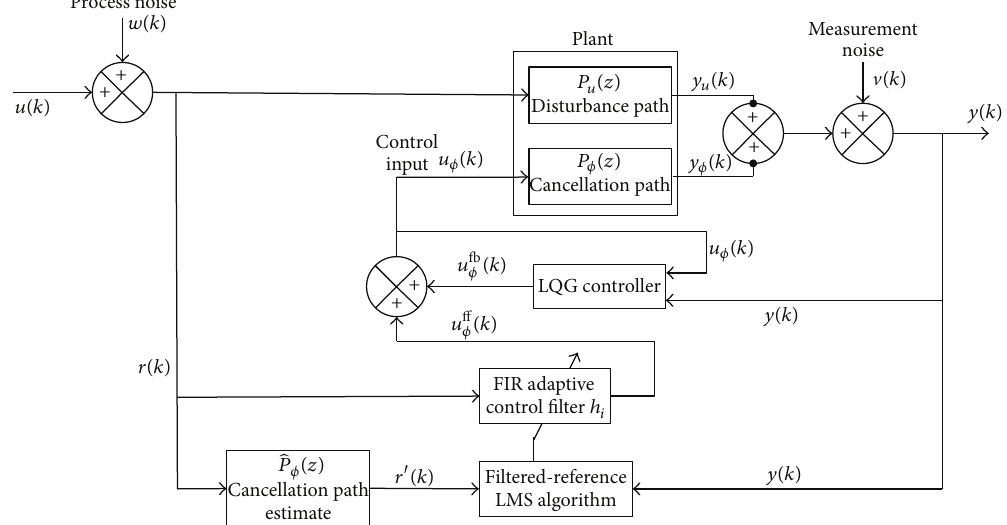
Figure 2: Schematic diagram of the generalized plant for hybrid (combined feedback/feedforward)